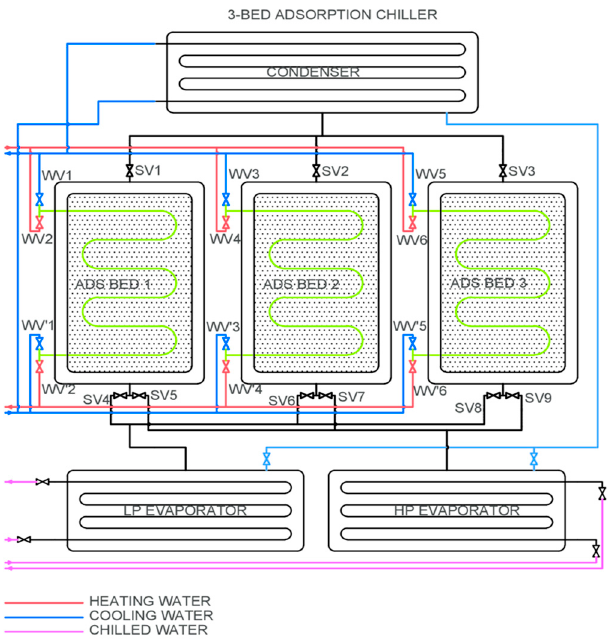
Figure 4. Three-bed two-evaporator adsorption chiller scheme. SV—steam valves, WV—water valves.